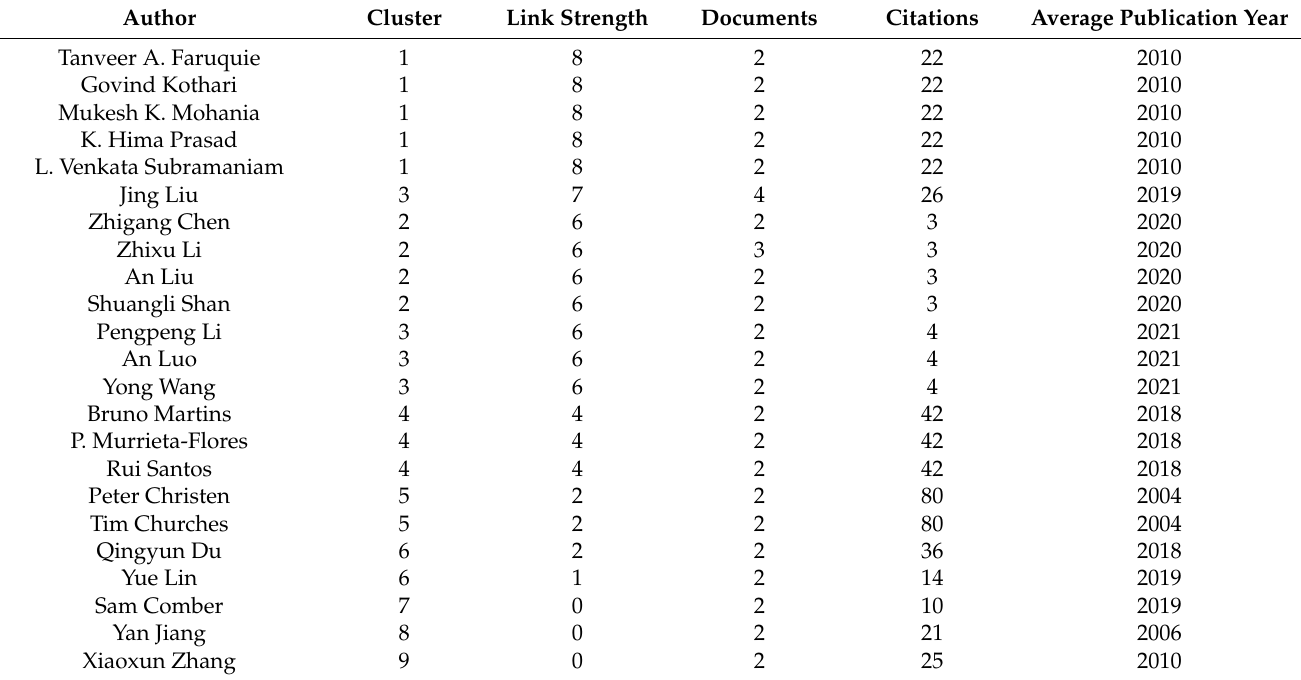
Table 5. Author co-authorship ranked by link